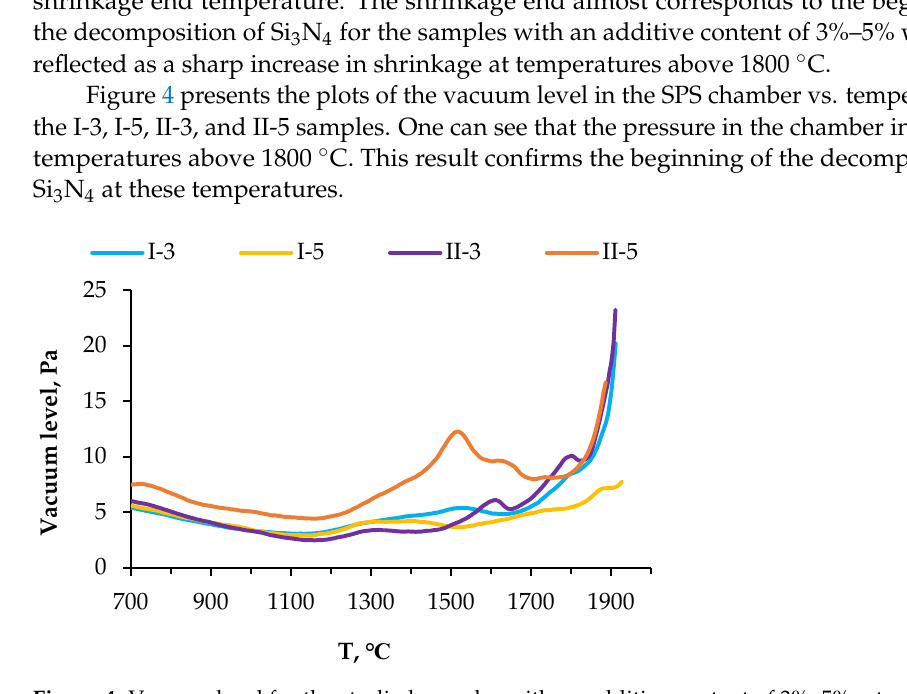
Figure 4. Vacuum level for the studied samples with an additive content of 3%–5% wt.